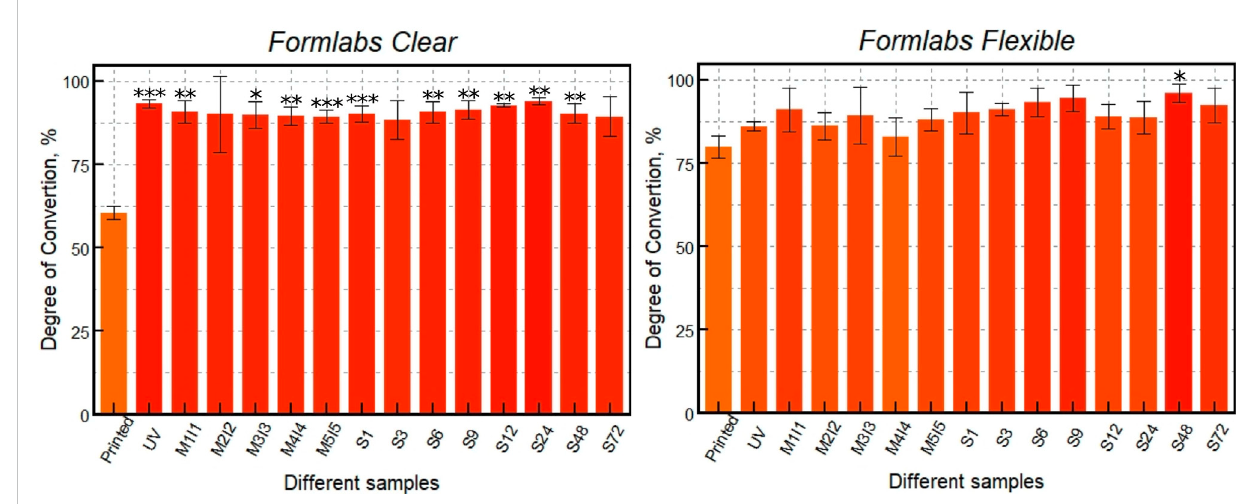
FIGURE 8 DCof3Dprintedscaffolds:justprinted,additionallyUVpost-cured(UV),post-curedanddifferentlypost-washed.***indicatesa p -valueof < 0.001, ** - p < 0,01 and * - p < 0,05 for post-processed samples compared to the just printed ones.